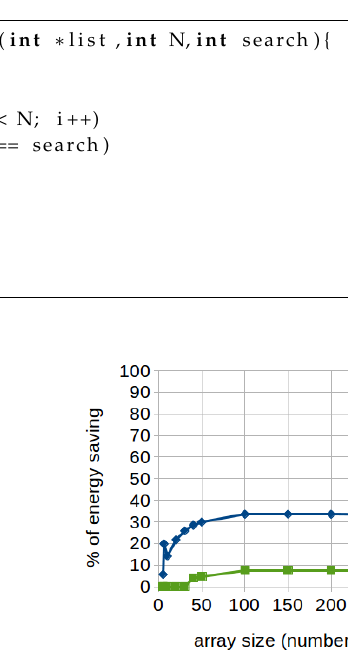
Figure 7. Linear search. Percentages of energy saving according to the array size (number of elements) in RPi 3B+ and